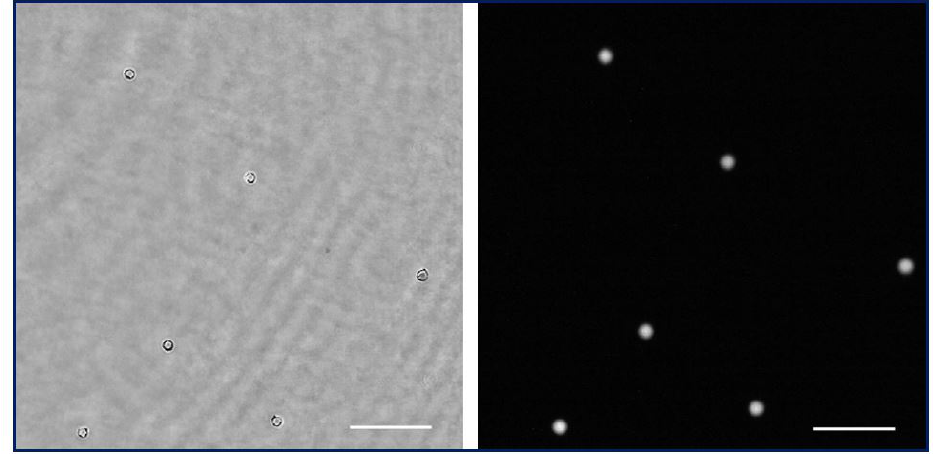
Figure 9. Simultaneous visualization of the phase retrieved by numeric propagation and fluorescence direct image of a low density fluorescent beads sample (Visualization 6 in the Supplementary Materials). Scale bar is 50 µm